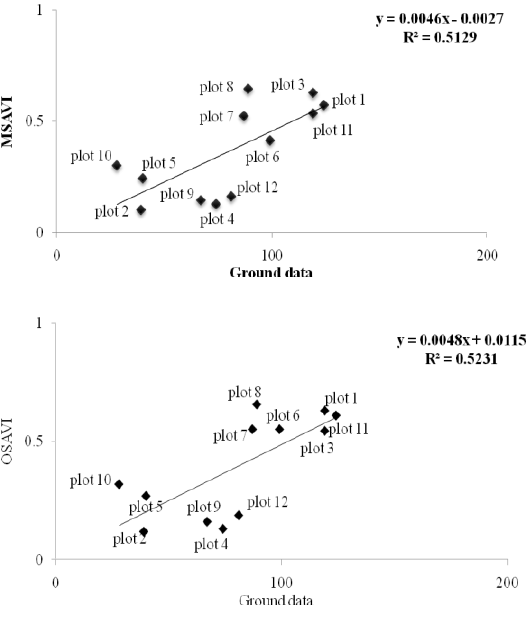
Figure 5. Relationships between tree density and vegetation indices (VIs)